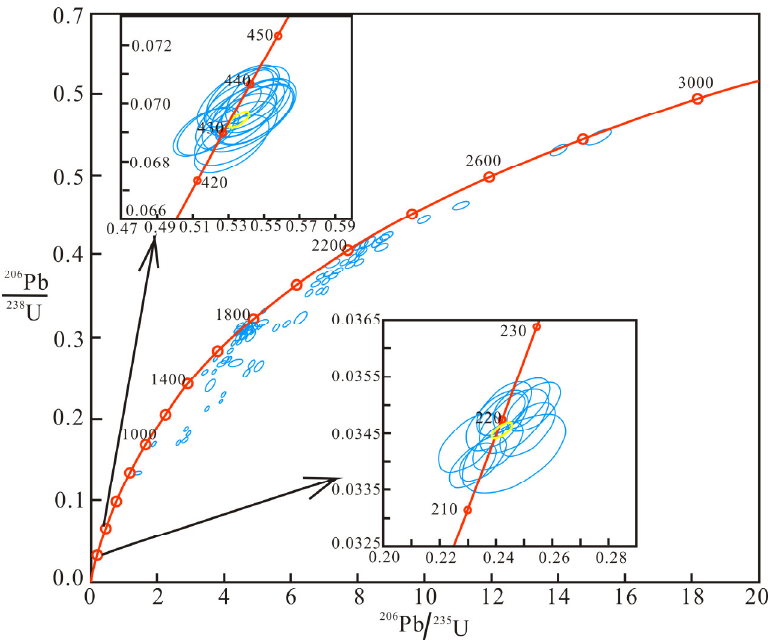
Figure 7. Zircon U–Pb concordia diagrams for the Zhiluo Formation sandstone. The blue circles on the diagrams show the concordia age spots, and the red circles show the age coordinate point on the concord.